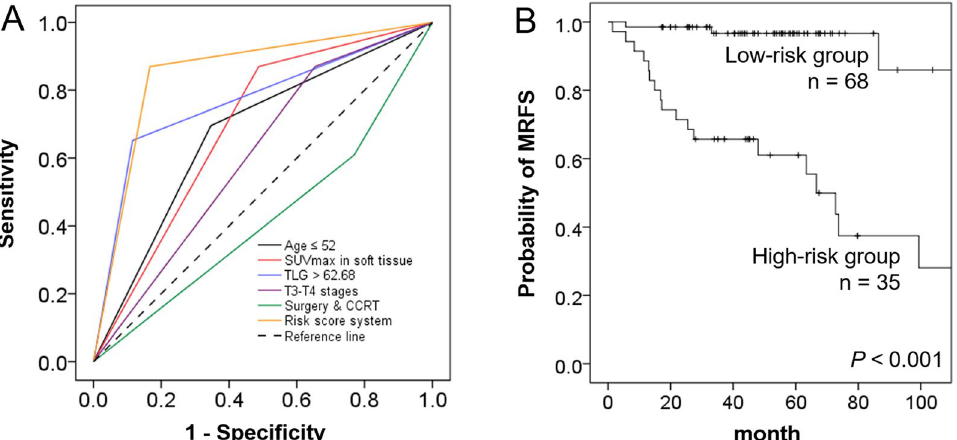
Fig. 2 Receiver operating characteristic curve analyses and C- indices for the prediction of MRFS ( A ). The C ‑index of the simple scoring system was higher than those calculated for other parameters. Kaplan–Meier plots of MRFS in patients with OSCC classified as being at low‑ versus high‑risk according to the simple scoring system ( B ). P values according to log‑rank tests are presented in the